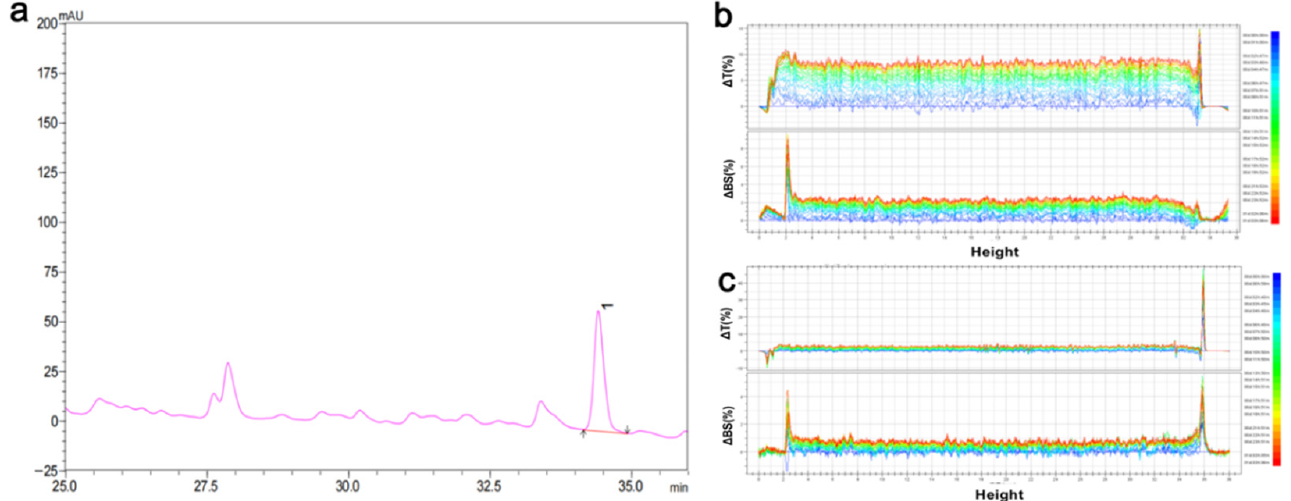
Figure 8. The properties of MGS-based drinking. ( a ) MGS content determined by HPLC; the light scattering spectra of ( b ) standard solution and ( c ) MGS-based drinking sample.